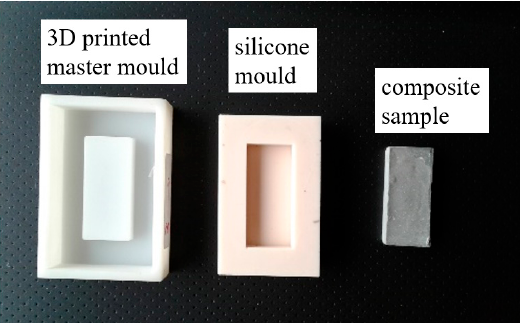
Figure 1. Three-dimensional (3D) printed master mold with silicone mold and an example of a composite sample.